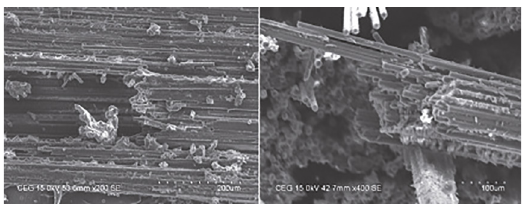
Figure 20: SEM micrographs of carbon/banana fiber composites subjected to impact loading